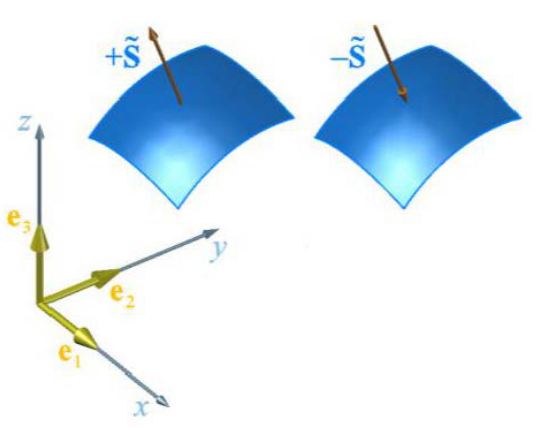
Figure 26: Positive and negative outer orientations of a surface.